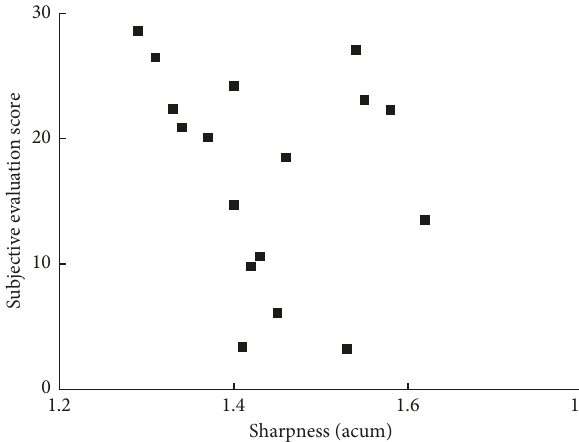
Figure 9: Correlation between sharpness and the subjective evaluation